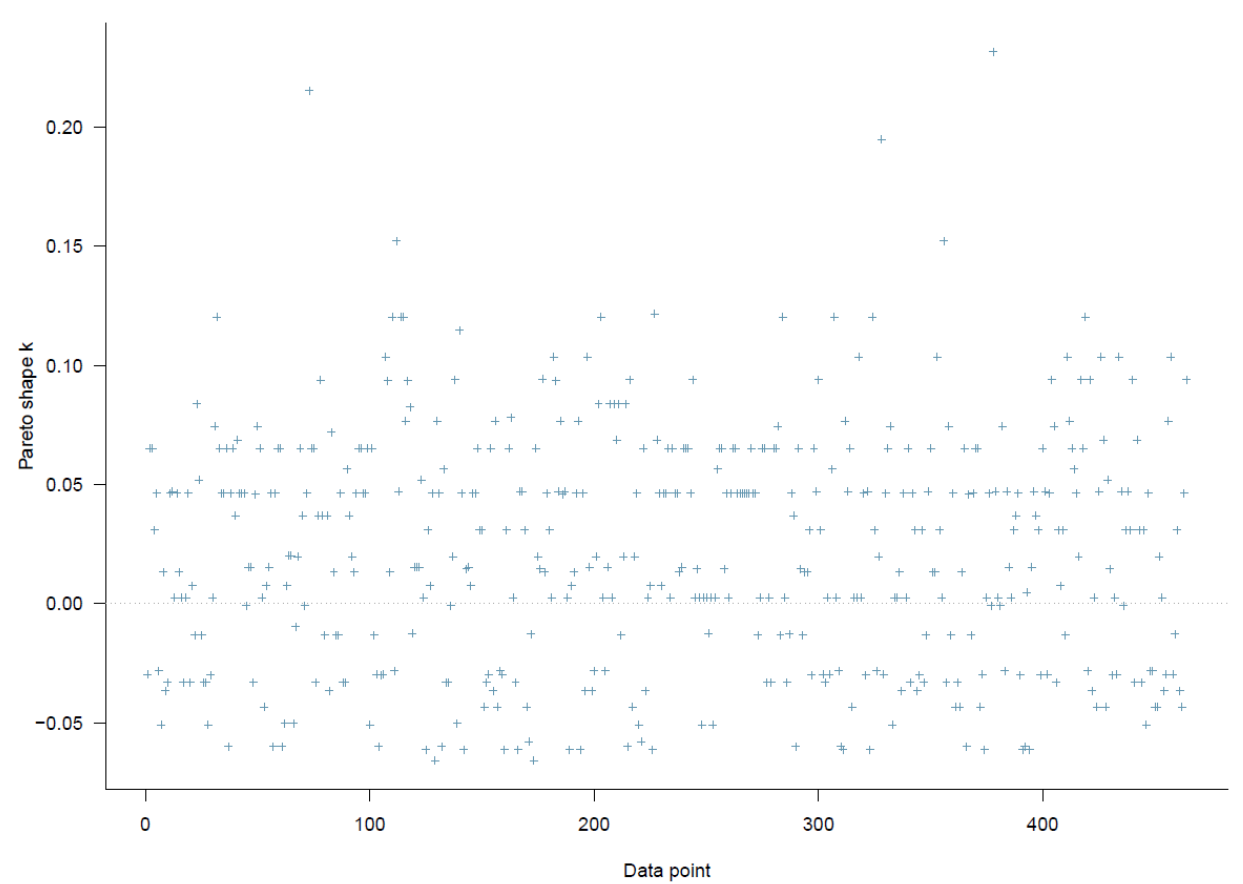
Figure 9. Model 2 (cid:48) s PSIS diagnostic plot. Figure 9. Model 2′s PSIS diagnostic plot.